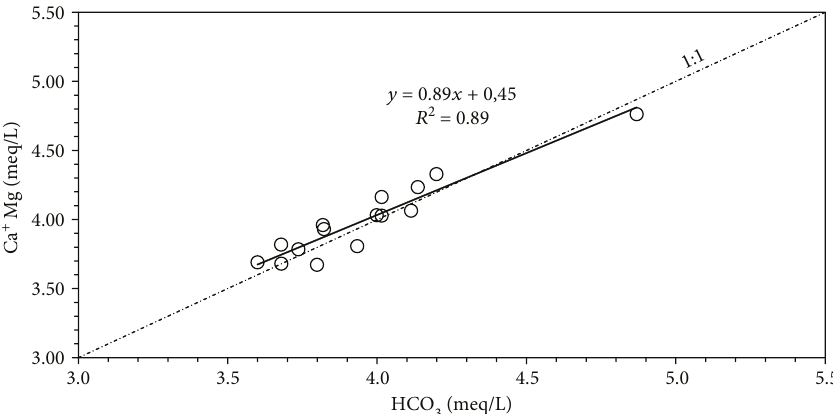
− = 1 . The black line displays the signi fi cant correlation 3